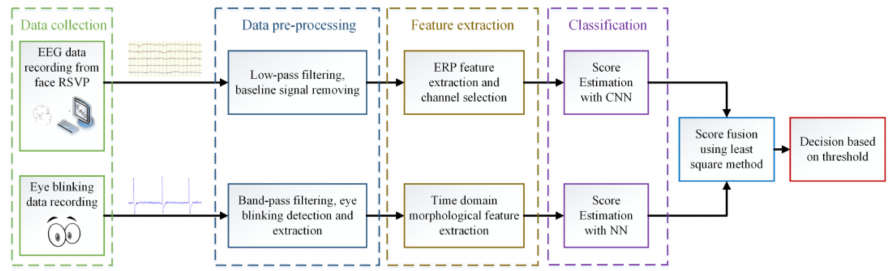
Figure 2. Flowchart of the multi-task authentication